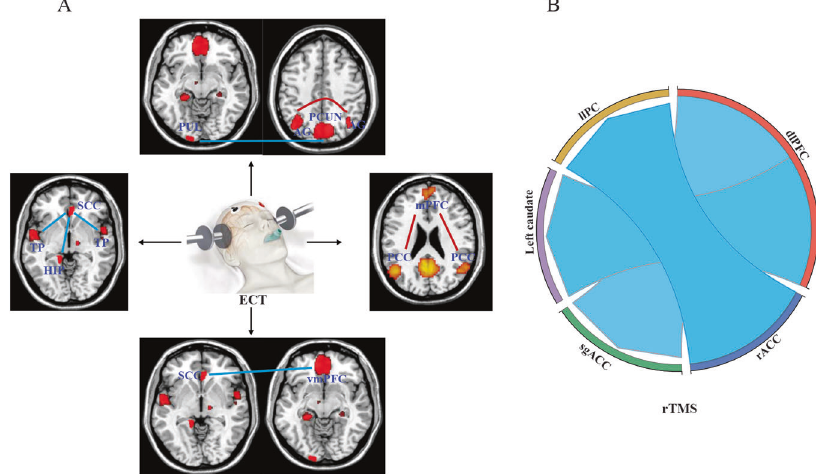
Fig. 6 Changes of brain functional connectome in MDD patients in response to electroconvulsive therapy (ECT). A and repeated transcranial magnetic stimulation (rTMS). B Blue lines indicated decreased functional connectivity (FC) after treatment and red lines indicated increased FC after treatment. PUL, Pulvinar; PCUN, Precuneus; SCC, Subcallosal cingulate cortex; TP, Temporal polar; HIP, Hippocampus; vmPFC, Ventromedial prefrontal cortex; mPFC, Medial prefrontal cortex; PCC, Posterior cingulate cortex; AG, Angular gyrus; llPC, left lateral parietal cortex; dlPFC, dorsolateral prefrontal cortex; rACC, rostral anterior cingulate cortex; sgACC, Subgenual anterior cingulate cortex.